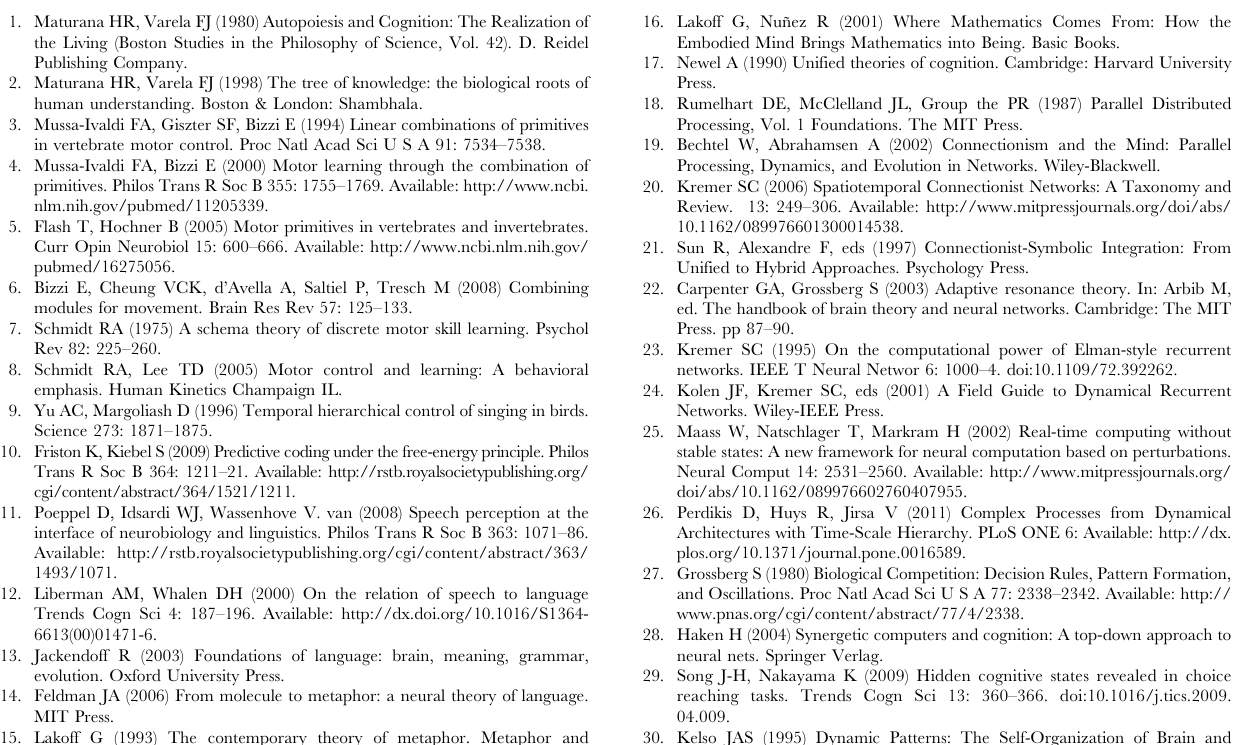
Figure S5 Time series analysis for s = 0.01 . Figure